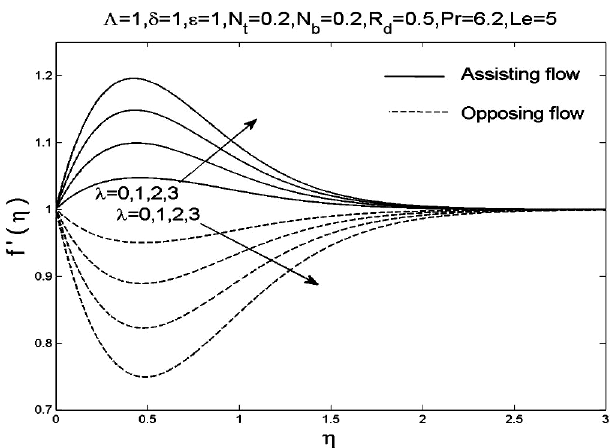
Fig. 3. The effect of the buoyancy parameter λ on the velocity profiles ( ) f η′